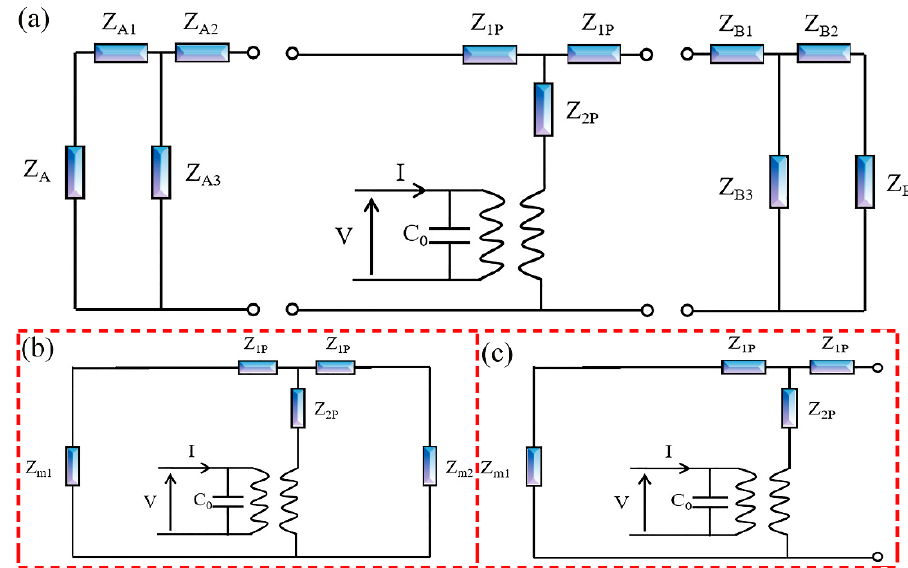
Figure 3. Equivalent circuit diagram of ultrasonic transducer, ( a ) the equivalent circuit of each component of transducer, ( b ) ultrasonic transducer composite equivalent circuit, ( c ) the equivalent circuit diagram of the left vibrator.